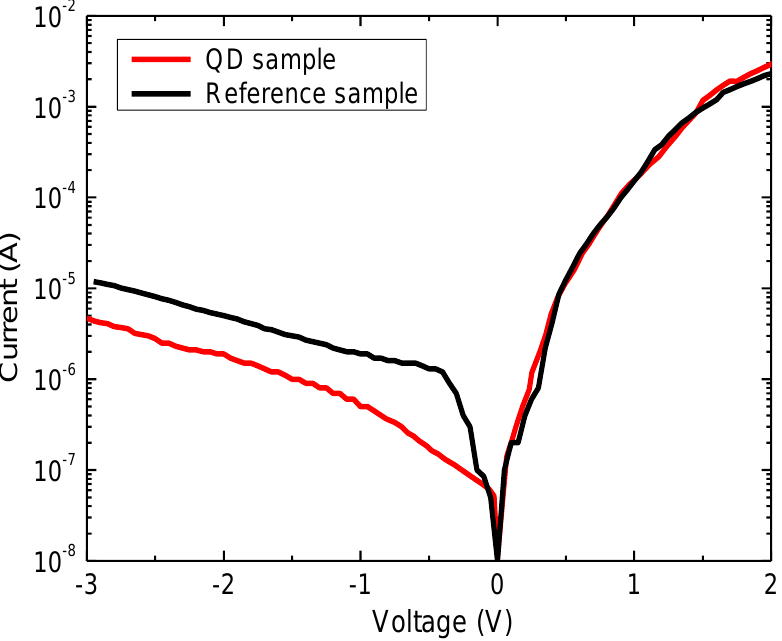
Figure 1. Current-voltage ( I-V ) characteristics of a reference- and quantum dot (QD) Ti/Al–ZnTe Schottky diode.